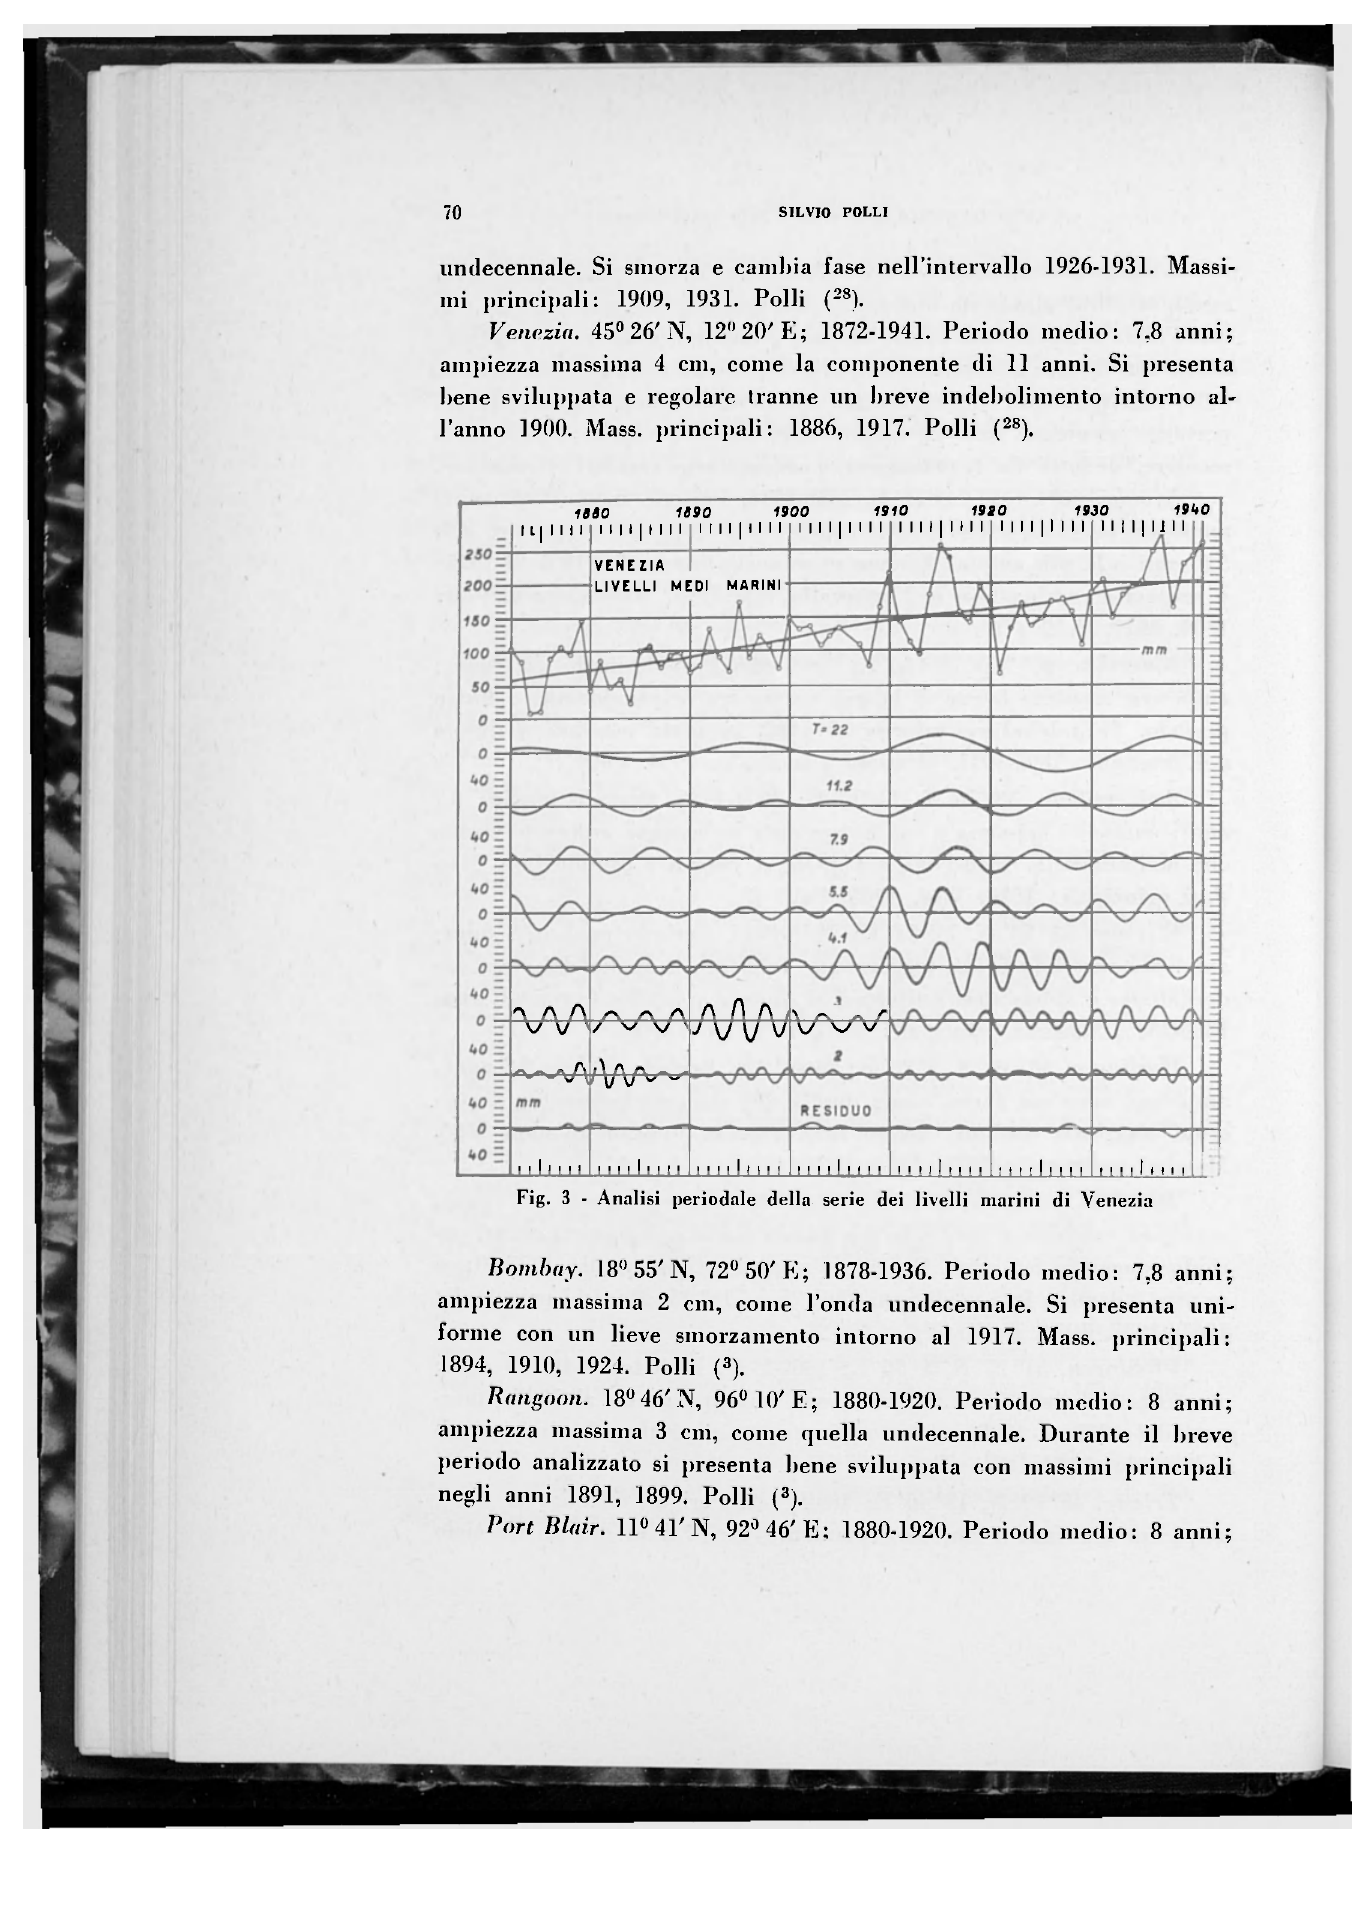
Bombay. 18° 55'N, 72° 50'E; 1878-1936. Periodo medio: 7,8